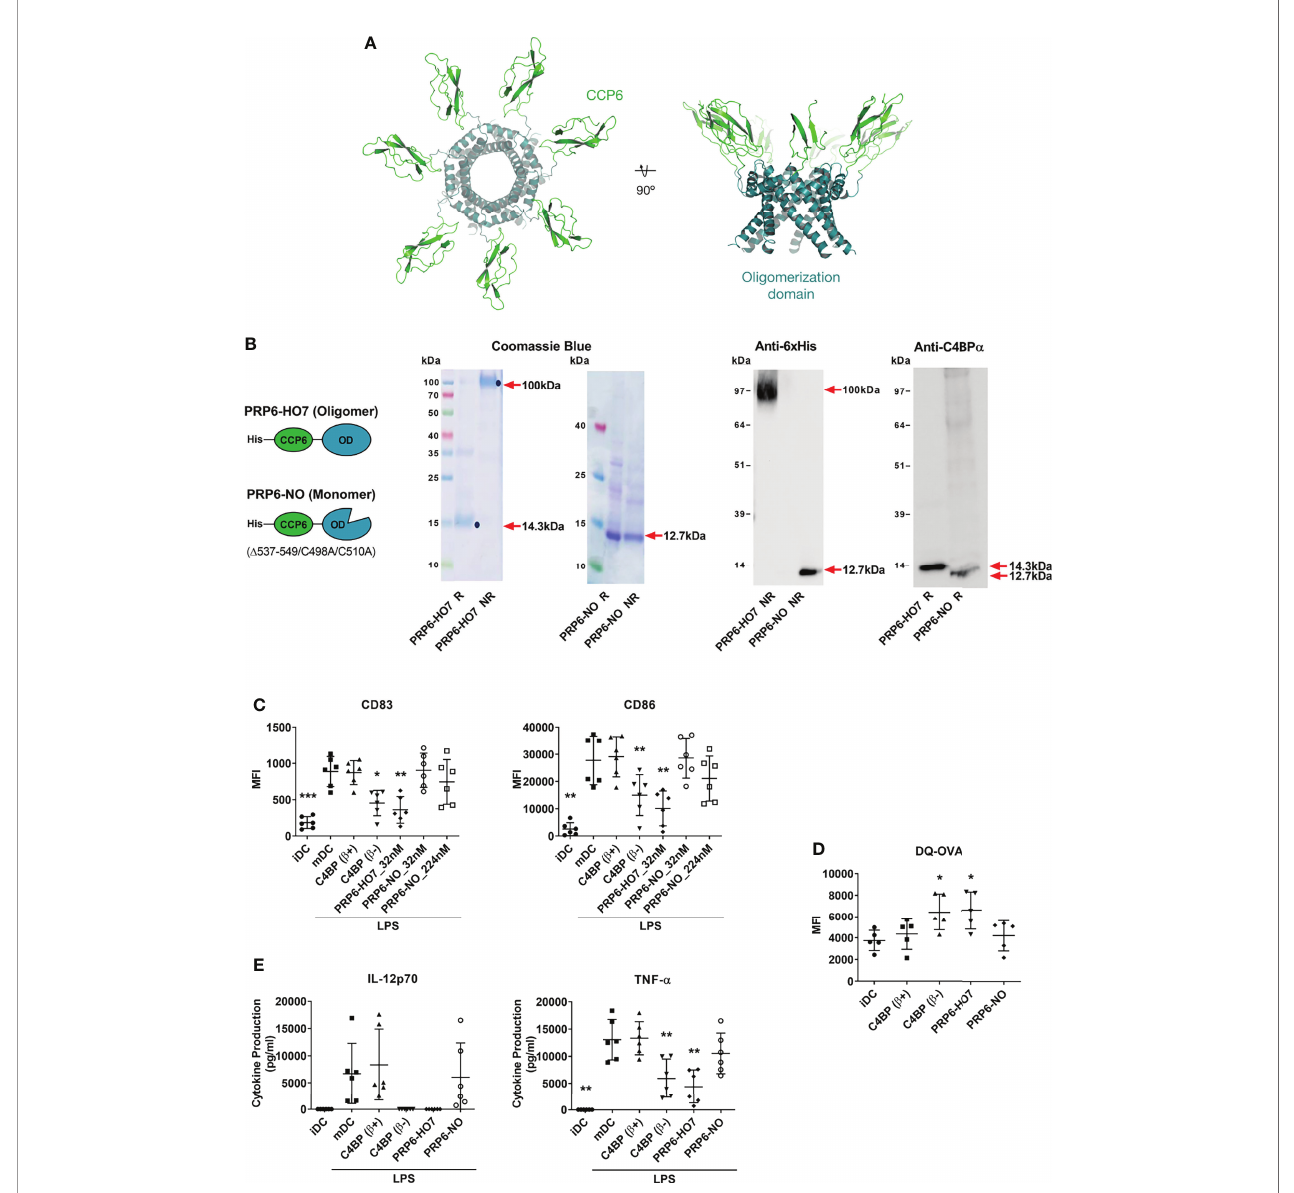
FIGURE 3 | Oligomerization is necessary to preserve the immunomodulatory activity of the C4BP a -chain CCP6 domain. (A) Molecular modeling of PRP6-HO7. PRP6-HO7 homo-oligomer structure prediction by comparative protein structure modeling with MODELLER. PRP6-HO7 is shown in cartoon representation. The N- terminal CCP6 domain and the C-terminal oligomerization domain are shown in green and blue, respectively. (B) Schematic structure of the monomer chain from the PRP6-HO7 heptamer, and from PRP6-NO, unable to oligomerize because of a mutated/truncated OD. PRP6-HO7 and PRP6-NO were visualized by SDS-PAGE and Coomassie Blue staining, and by Western analysis against anti-His and anti-C4BP a -chain antibodies, under both reducing (R) (PRP6-HO7 monomer, 14.3 kDa; PRP6-NO, 12.7 kDa) and non-reducing (NR) (PRP6-HO7 oligomer, 100 kDa; PRP6-NO, 12.7 kDa) conditions. Red arrows indicate the respective molecular weights. (C) Human Mo-DCs were incubated throughout their differentiation process with C4BP( b +), C4BP( b -) (both at 12 nM) and the variants PRP6-HO7 and PRP6-NO (both at 32 nM, unless otherwise stated). DC maturation was achieved by LPS treatment. Cells were then collected, washed, and analyzed by fl ow cytometry for cell surface expression of the activation marker CD83 and the co-stimulatory molecule CD86. MFI, median fl uorescence intensity for the different surface markers. The results shown are the mean ± SD from 6 independent donors (*p < 0.05; **p < 0.01; ***p < 0.001 compared with mDC). (D) Comparative endocytic activity of Mo- DCs was also assessed by fl ow cytometry, measuring fl uorescent DQ-OVA internalization (receptor-mediated endocytosis) at the differentiation stage, after treatment with C4BP( b +), C4BP( b -), PRP6-HO7, and PRP6-NO. Data shown are the mean MFI ± SD from 5 independent experiments (*p < 0.05 compared with iDC). (E) The concentrations of IL-12p70 and TNF- a were analyzed in the cell supernatants from (C) , except the PRP6-NO_224 nM sample, by ELISA. iDC, untreated, immature DCs; mDC, untreated, LPS-matured DCs. The results shown are the mean ± SD from 6 independent donors performed in duplicate (**p < 0.01 compared with